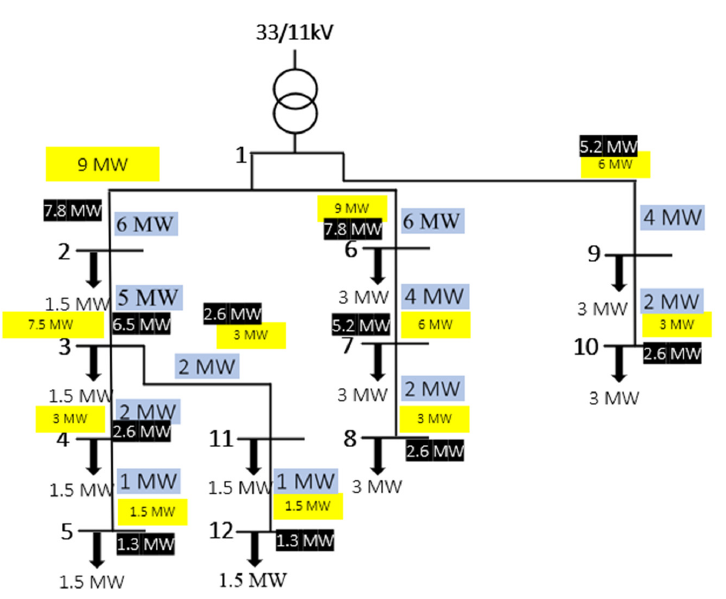
Figure 6. Schematic diagram of the HV electricity grid showing the first-stage power flows (in blue), the initial line thermal limits (in black), and the second-stage peak load (downward black arrows)